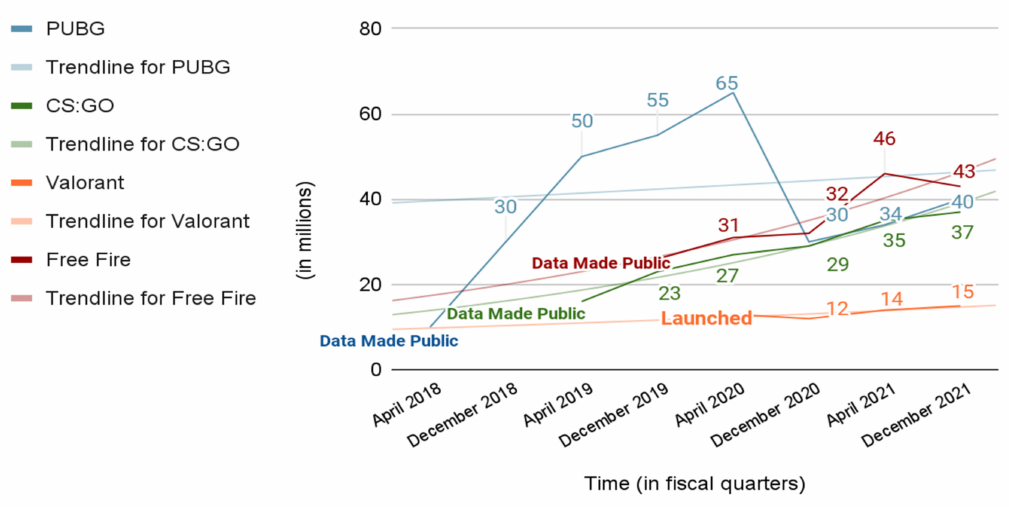
Figure 3. Growth in daily active users of different shooter-type video